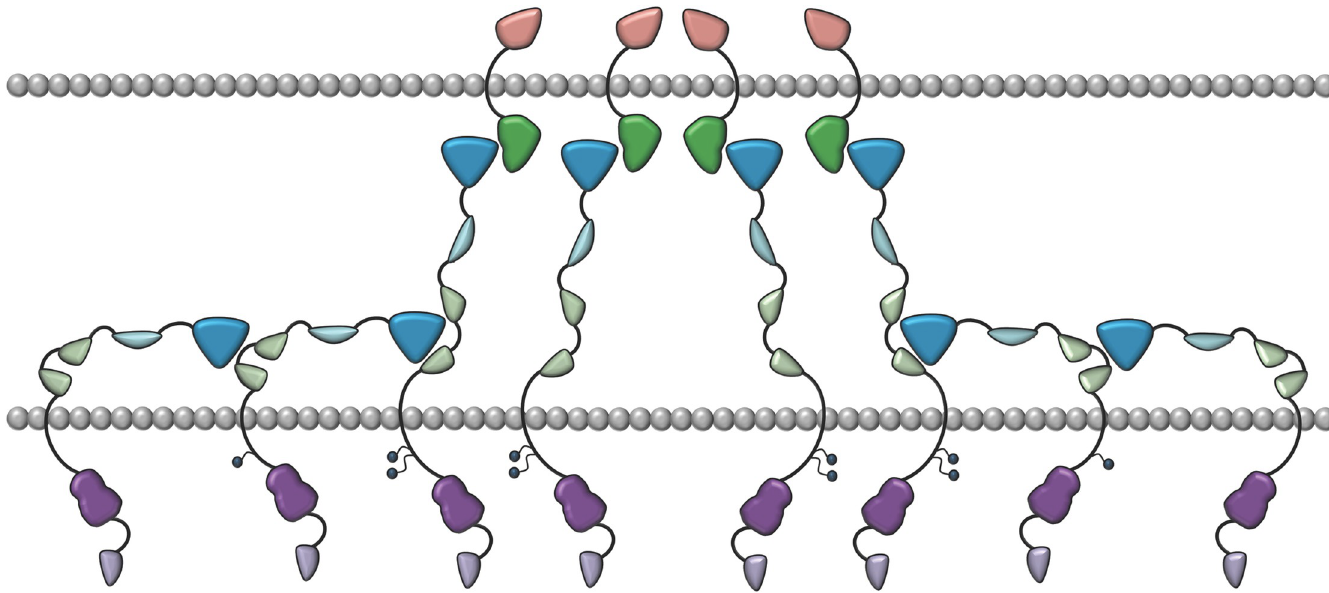
Fig 7. Schematic representation of the head to tail Eph-ECD interactions. The Eph receptors are in blue/green/purple and are interacting with the ephrins in green/ orange. The LBDs of the ephrin-free Ephs (in blue) and the FN3 regions (in light green) of their neighbors are interacting. Intracellular, juxtamembrane Tyrosines are shown as small circles. They get fully phosphorylated only when biologically active heterotetramers and higher-order Eph/ephrin assemblies form after the initial ligand binding events. The cell membrane of the two interacting cells are in grey.